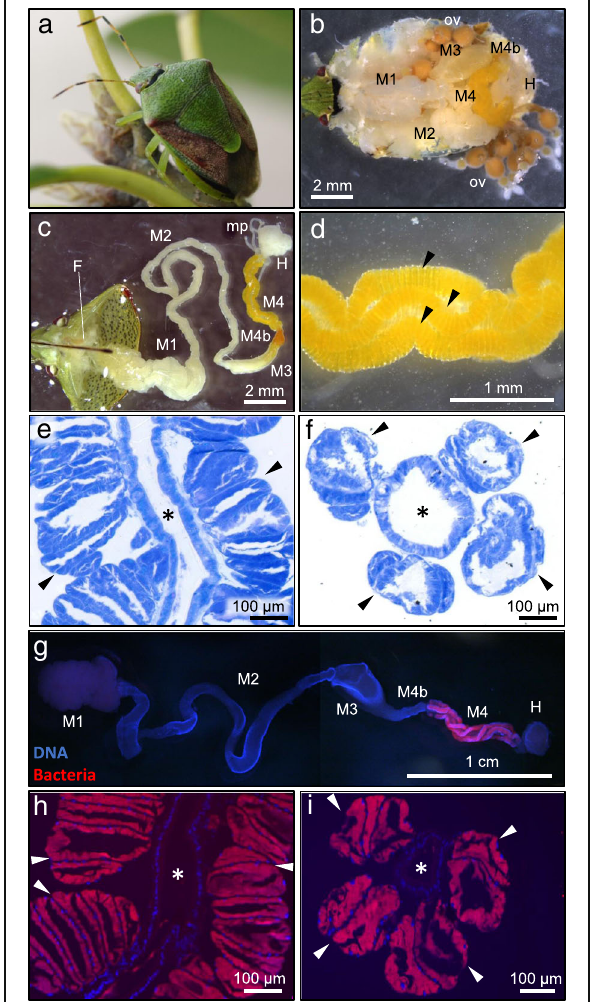
Fig. 1 Symbiotic organ of P. stali. a An adult insect. b Dorsal view of a dissected insect. c An isolated alimentary tract, in which M4 represents the symbiotic organ. d An enlarged image of the symbiotic organ with numerous crypts in four rows. Three rows are seen (arrowheads), whereas another row is behind. e , f Toluidine blue staining of a longitudinal section ( e ) and a cross section ( f ) of the symbiotic organ. g FISH detection of the symbiotic bacteria in a dissected alimentary tract. h , i FISH detection of the symbiotic bacteria on a longitudinal section ( h ) and a cross section ( i ) of the symbiotic organ. In g – i , blue and red signals indicate host ’ s nuclear DNA and symbiotic bacteria, respectively. Arrowheads and asterisks show the crypt rows and the main tract of the midgut symbiotic organ, respectively. Abbreviations: F, foregut; M1, midgut first section; M2, midgut second section; M3, midgut third section; M4b, bulb-like section aboral to M4; M4, midgut fourth section, the symbiotic organ with crypts; H, hindgut; ov, ovary; mp, Malpighian